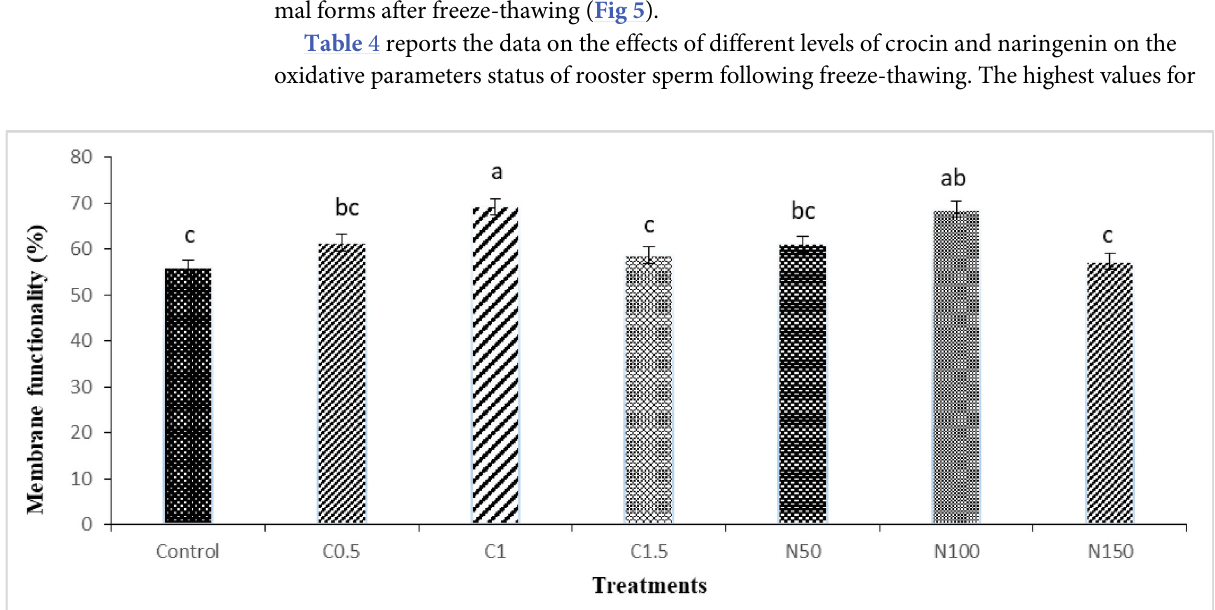
PLOS ONE | https://doi.org/10.1371/journal.pone.0241105 October 29,